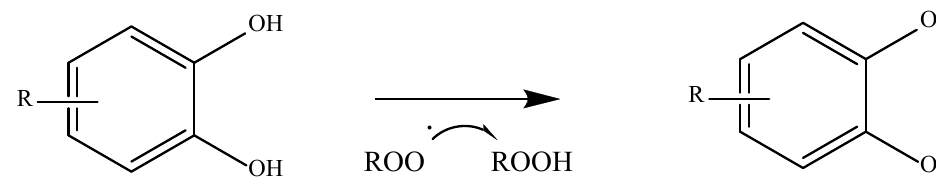
Figure 2. Phenolic acid derivative neutralizing a free radical via HAT [46]. Another mechanism widely used by phenolic acids is the so-called SET or single electron transfer. In this case, the antioxidant gives up an electron to the free radical to stabilize it in an anionic form as shown in Figure 3 [46,53].